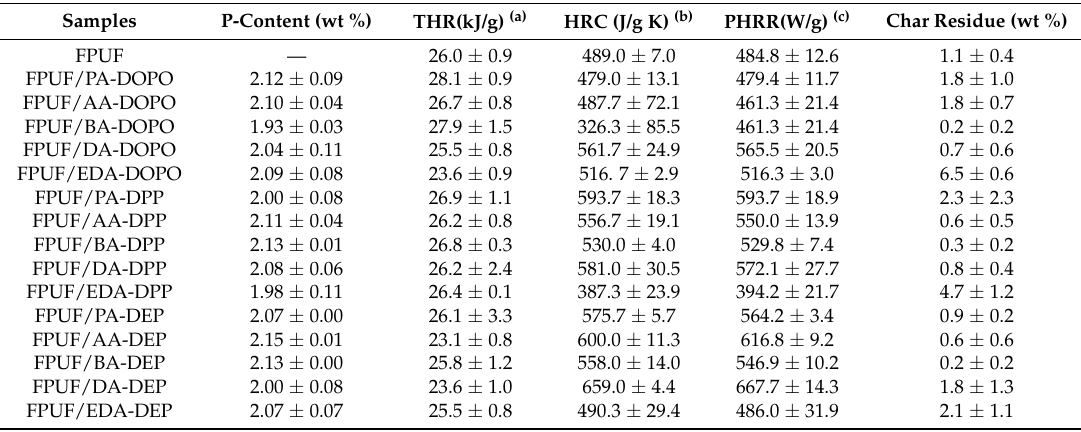
Table 5. Detailed data of FPUF and flame retarded FPUF from MCC.